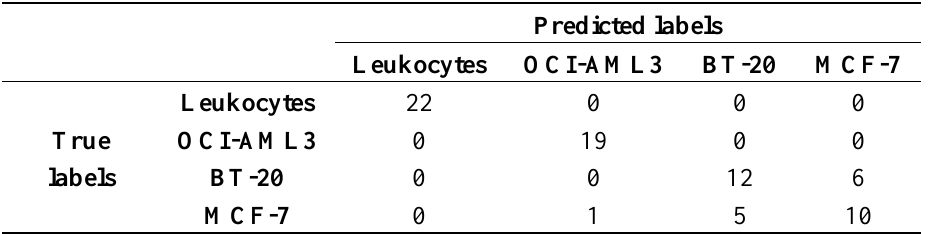
Table 1. Confusion table for individual cells of the classification model (SVM with linear kernel) for the evaluation with 10fold cross validation. On the cell level a prediction accuracy of 84% can be achieved.